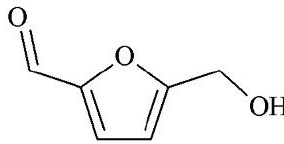
Figure 1. Chemical structure of HMF.